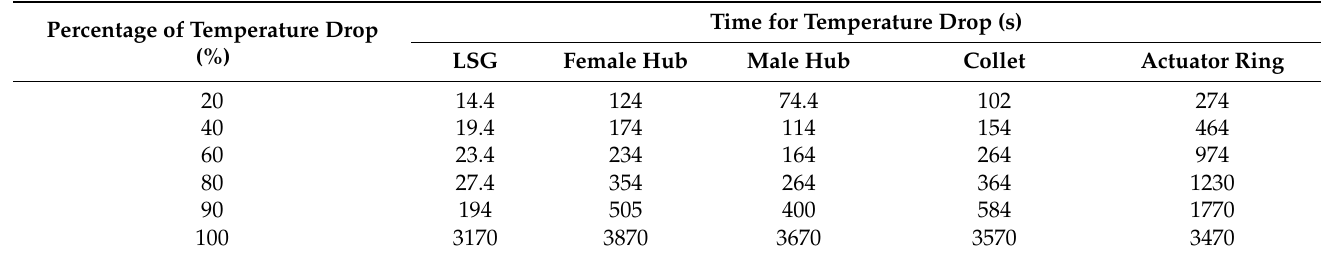
Table 3. The time required for each component to drop to the seawater temperature under the working condition of uniform temperature drop.